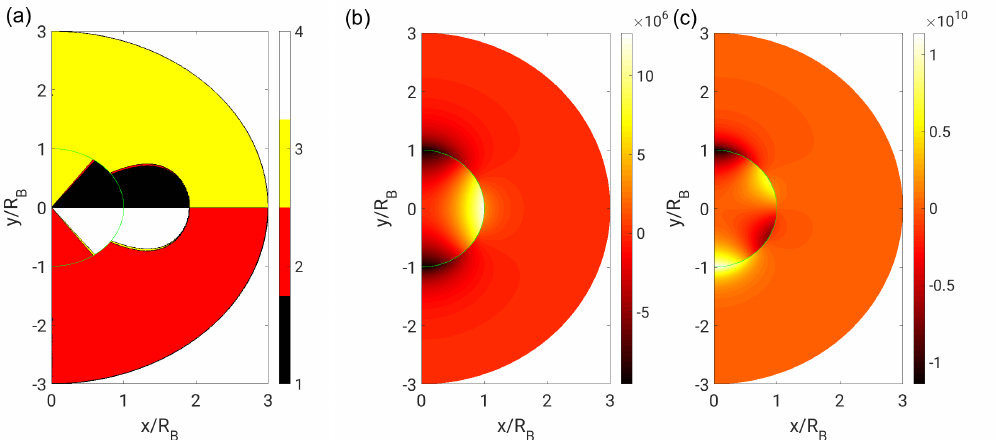
Figure 8. ( a ) Flow topologies; ( b ) second invariant Q ; and ( c ) third invariant R in the bubble case ( ξ = 0.0182) with near-field boundary conditions ( r W = 3 r B